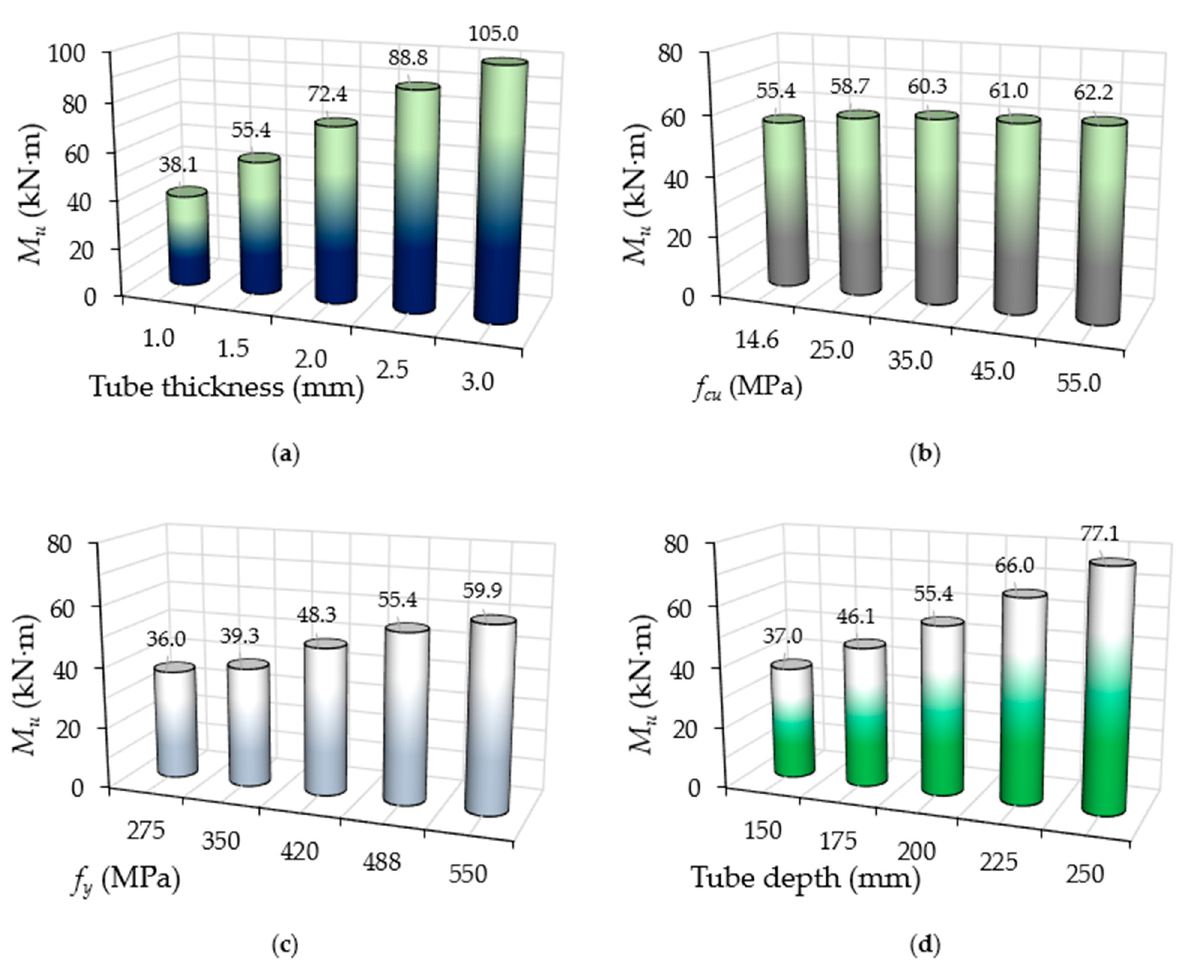
Figure 11. Effects of the M u values of CFST models with varied parameters: ( a ) group A; ( b ) group B; ( c ) group C; ( d ) group D.